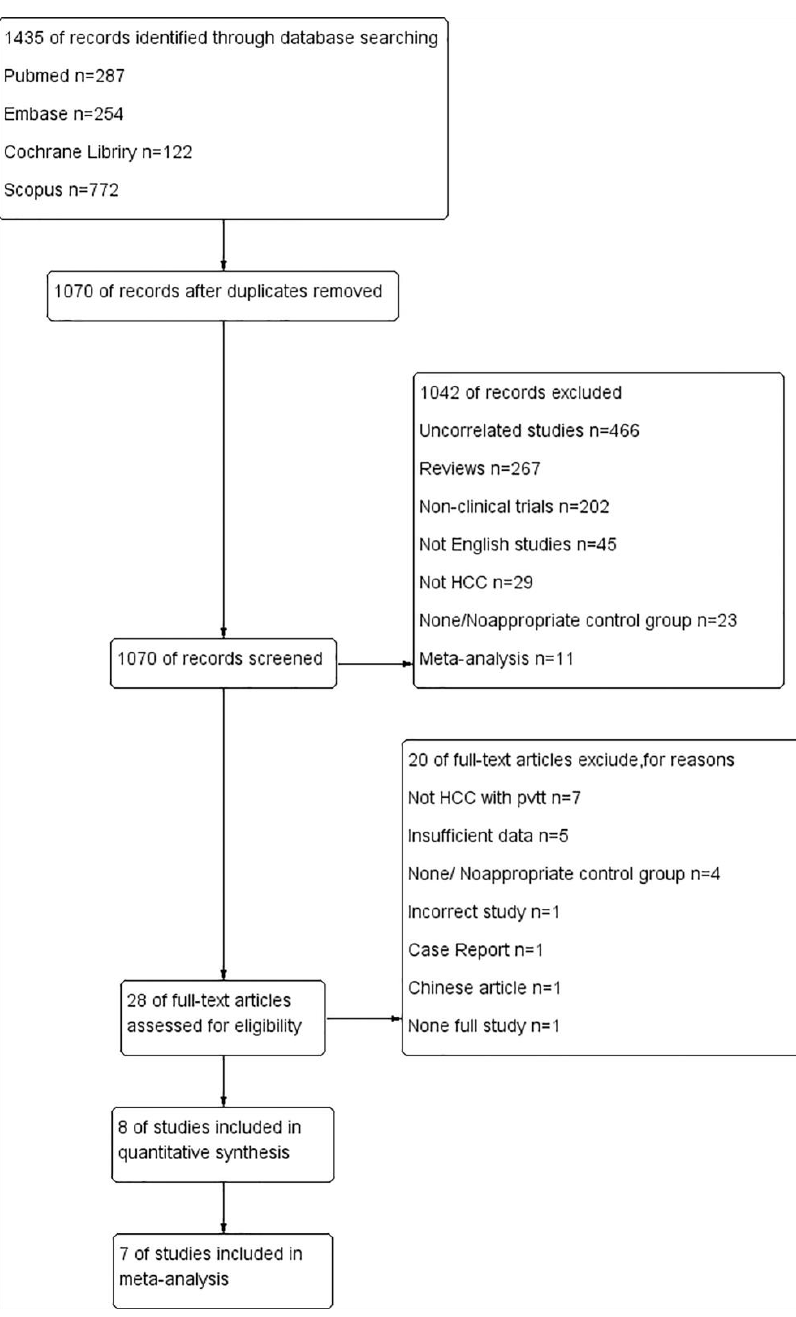
Figure 1. Flowchart for selection of included studies.